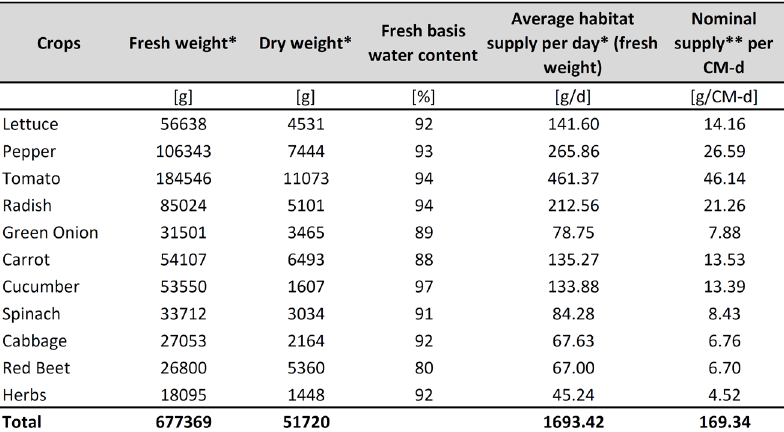
Table 7: Biomass results for SC approach and fresh weight water content. The values were mainly derived from BVAD (Anderson et al. 2015).